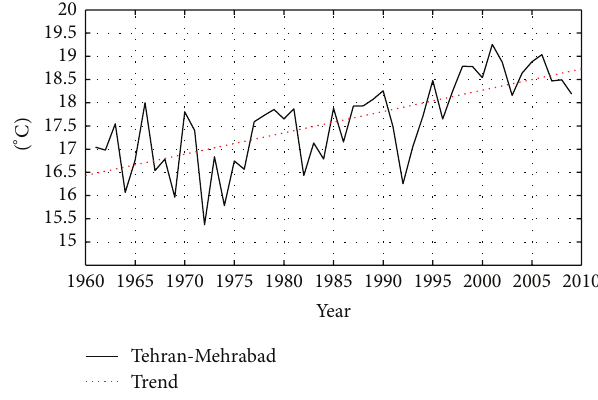
Figure 6: Mean annual 2 m Temperature from 1951–2009 in Tehran Mehrabad